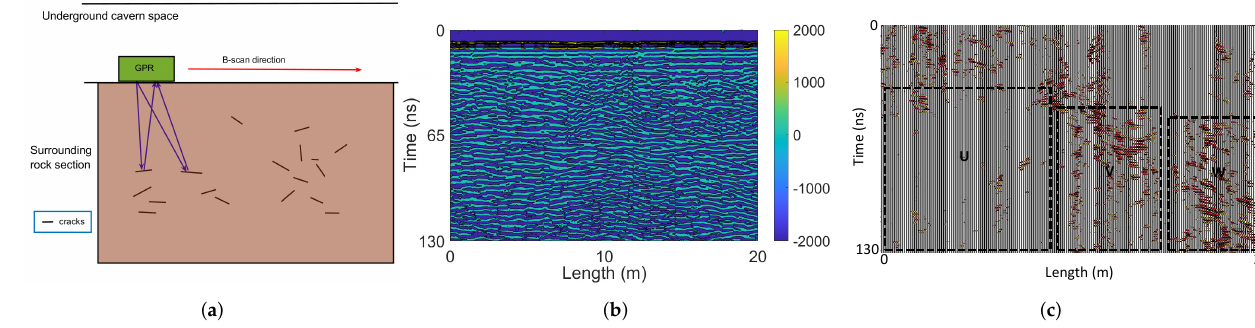
Figure 3. ( a ) A simple scheme of field measurements. ( b ) The original radargram. ( c ) The radargram processed by expertise.